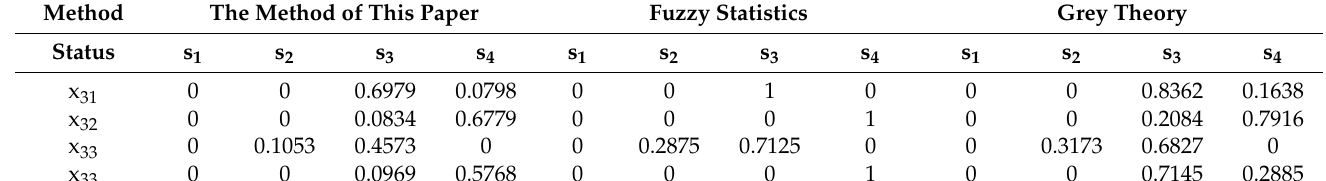
Table 4. Membership solution results of x 31 , x 32 , x 33 , and x 34 under different methods.